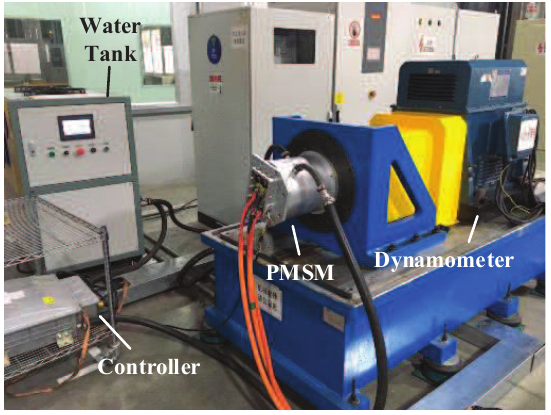
Figure 8. Experiment